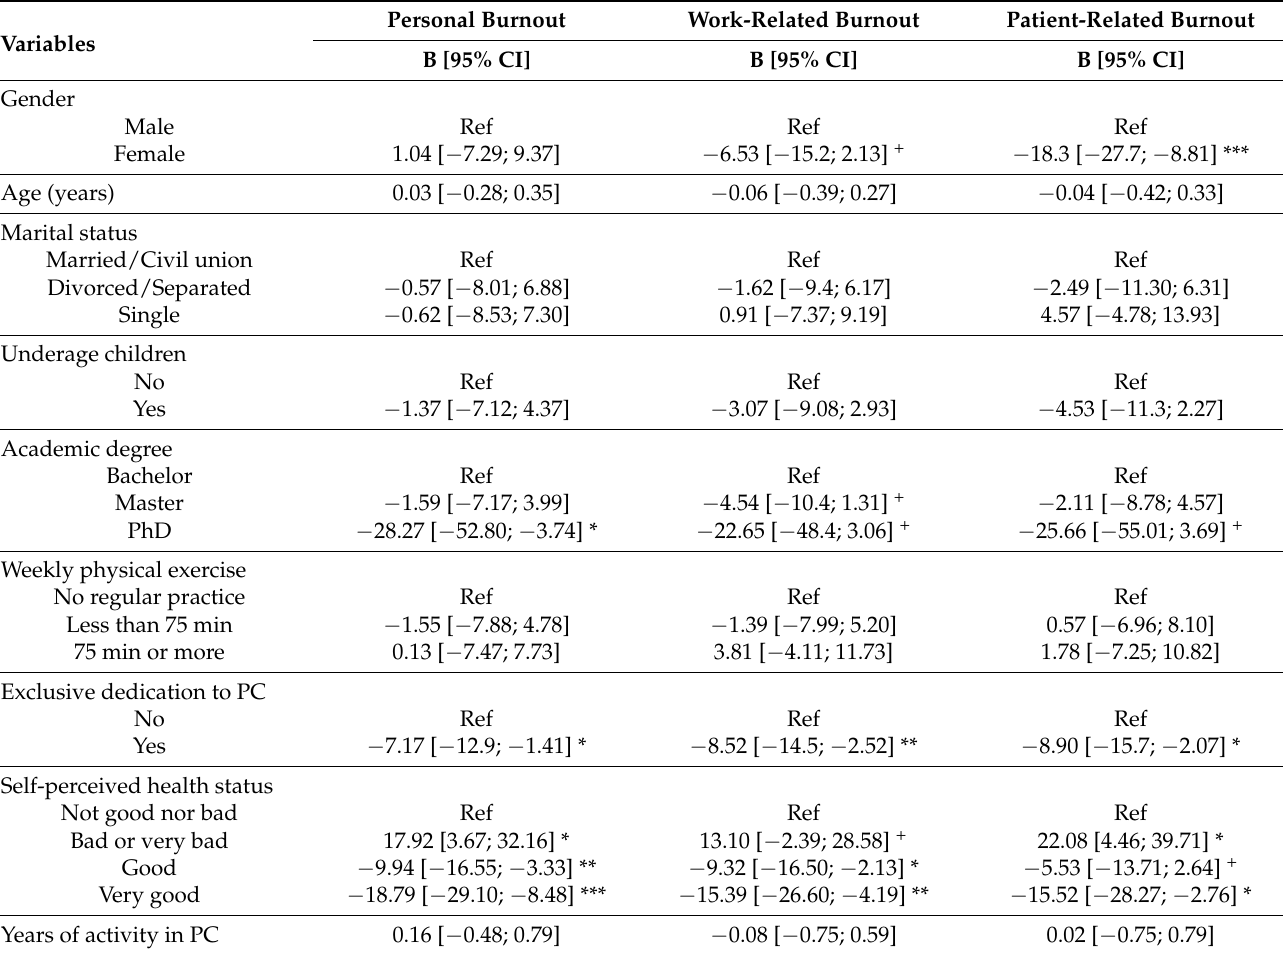
Table 1. Unstandardized regression coefficients of univariable models for the subscales of burnout according to CBI as outcomes and personal, work and COVID-19 variables as